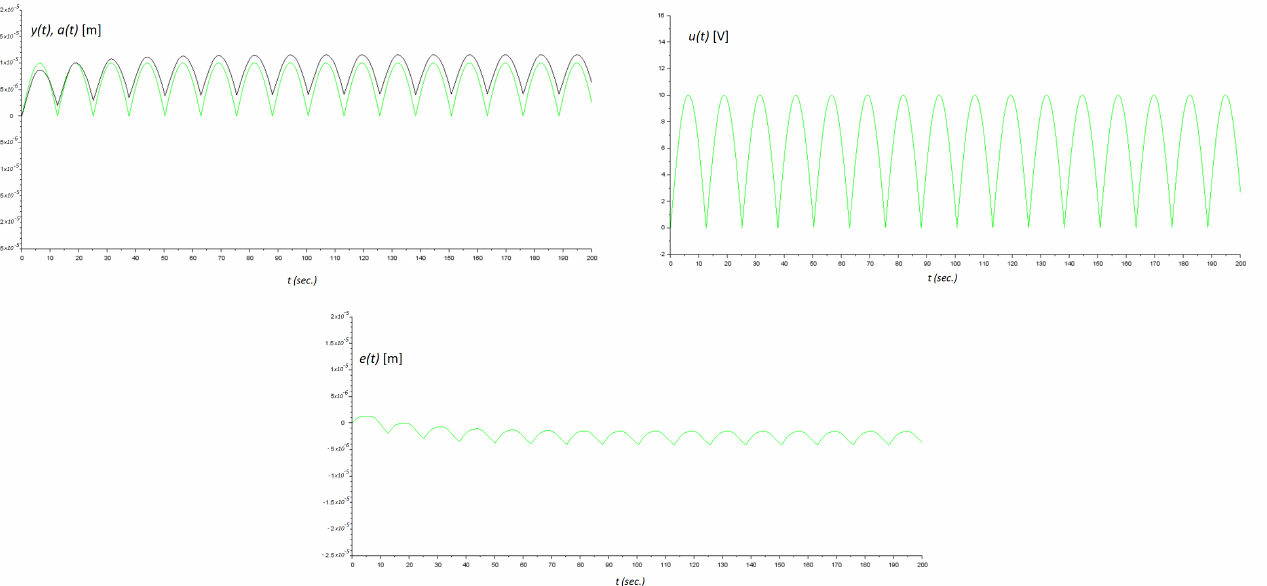
Figure 10. Results of numerical experiments. Top left: the green line is the reference signal a ( t ) and the black line is the position response of the micromachine y ( t ) . Top right: control signal u ( t ) . At the bottom: Error signal between system output and reference command e ( t )